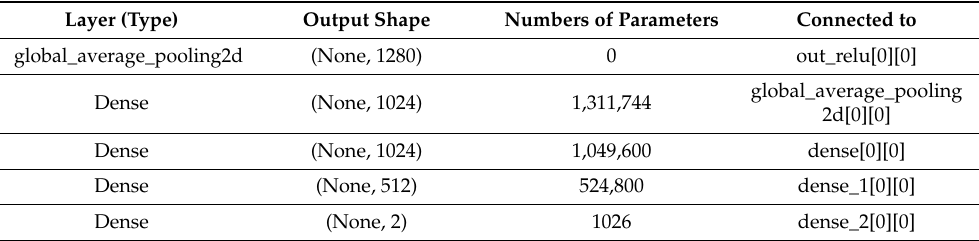
Table 2. The internal details of the proposed MobileNetV2 for activity recognition.